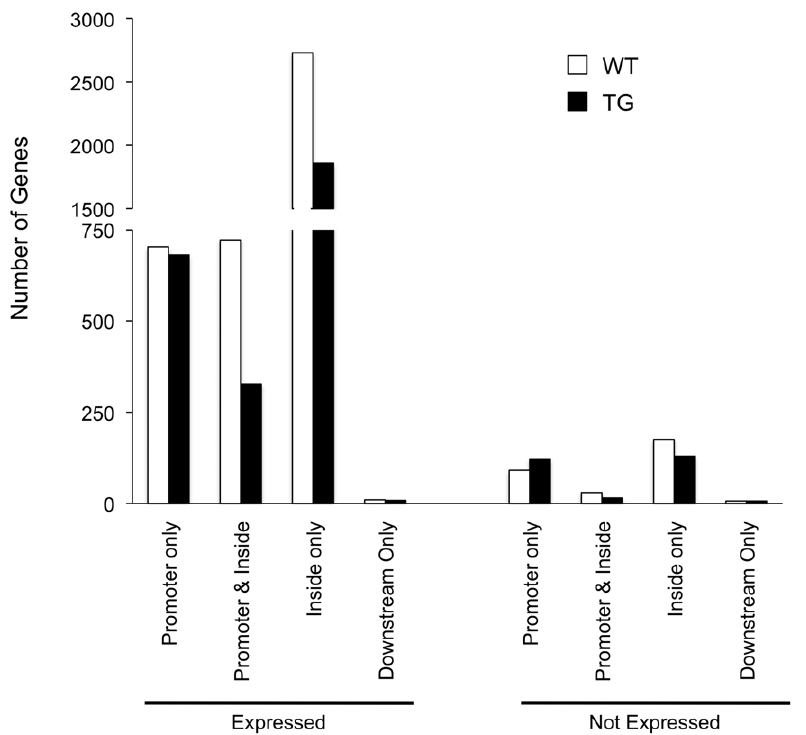
Figure 7. AcH3-localization within the gene changes upon gene expression. AcH3-localization within the gene changes on transcriptional status of the gene. White bars, WT; black bars, TG. doi:10.1371/journal.pone.0041423.g007 PLoS ONE |